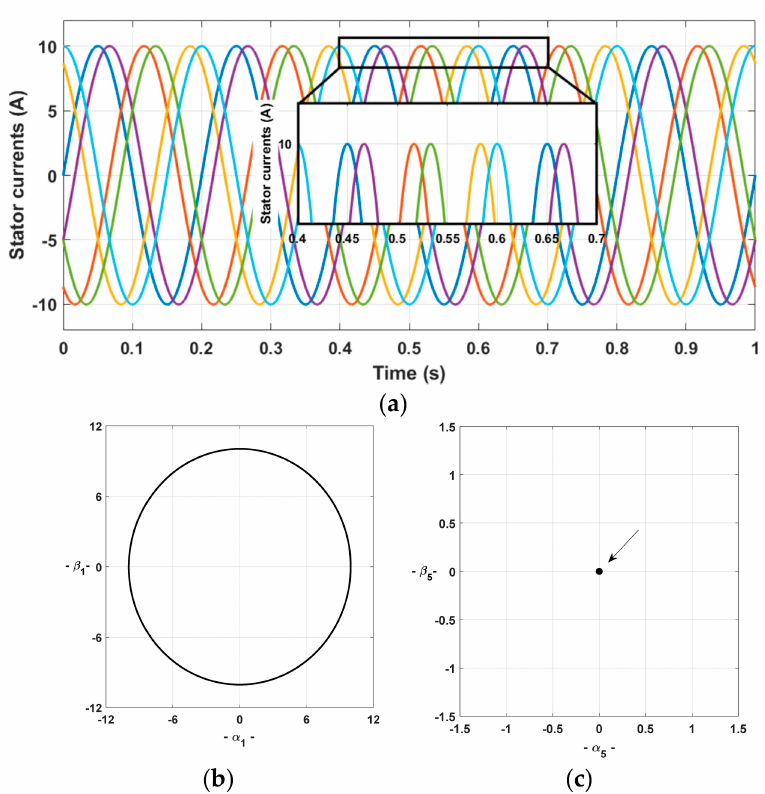
Figure 5. Simulation results: behavior of the drive using the proposed improved field-oriented waveforms; ( b ) current space vector in α 1 – β 1 plane; ( c ) current space vector in α 5 – β 5 plane.